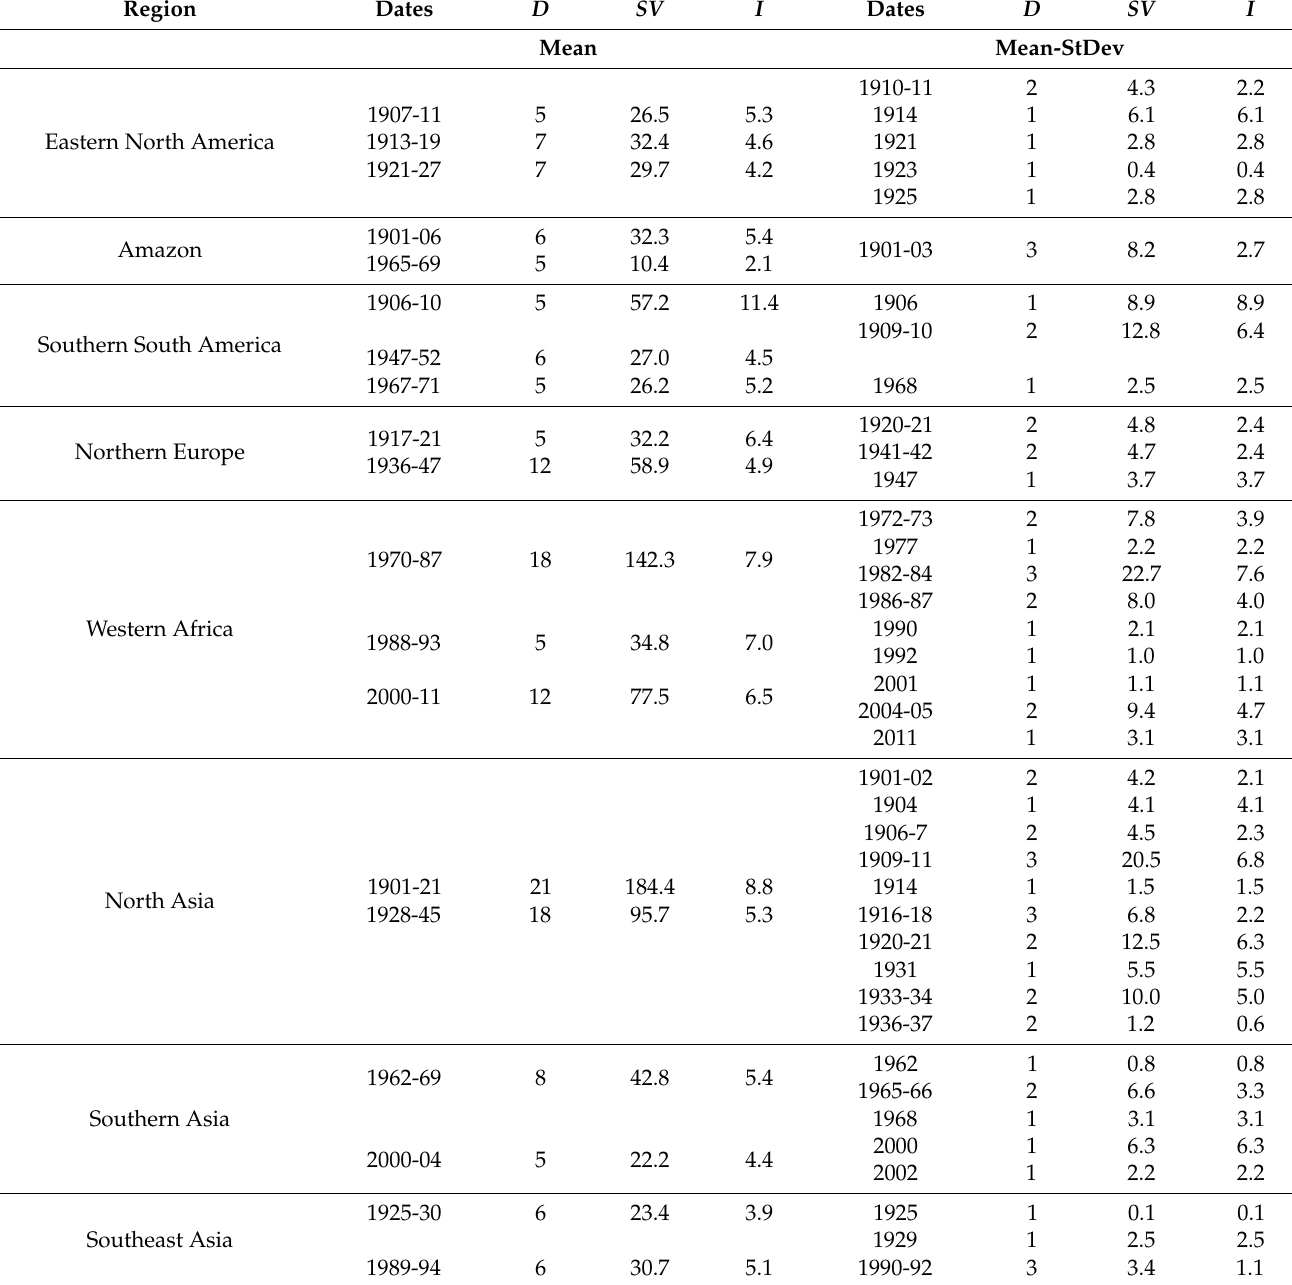
Table 3. Deficit periods ( D ) of more than 5 years below the mean, with percentage volumes ( SV ) and intensities ( I ), for average area precipitation for the 8 LTP regions for the period 1901–2013. Embedded deficits below MSD, with percentage volumes and intensities, are also